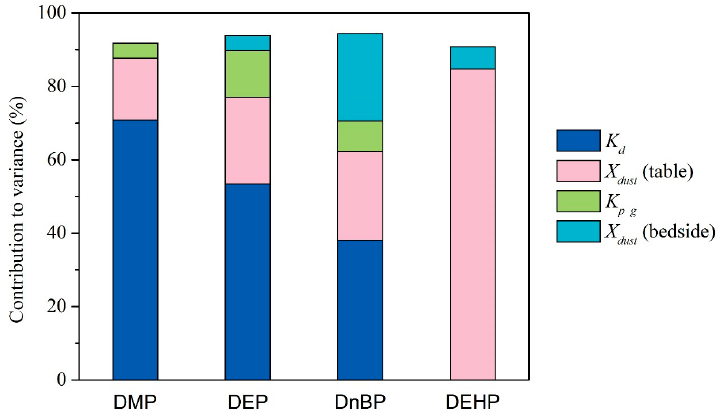
Figure 3. Sensitivity of major input parameters to total exposures.